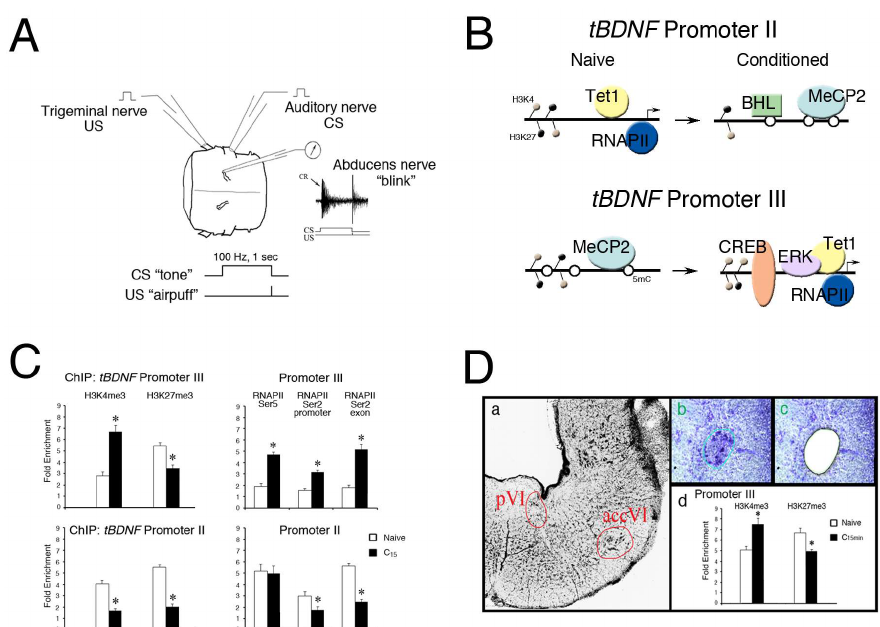
Figure 1. ( A ) Model of in vitro eyeblink classical conditioning. Illustration of the preparation of the pons isolated from the turtle brain showing cranial nerves that are stimulated and recorded. Classical conditioning is generated by paired stimulation of the auditory nerve (the “tone” conditioned stimulus, CS) with the trigeminal nerve (the “airpuff” unconditioned stimulus, US) while recording activity in the ipsilateral abducens nerve which controls blinking in this species. A physiological trace of abducens nerve discharge representative of a neural correlate of a “blink” conditioned response (CR, arrow) is shown. Pairing consists of a 100 Hz, one-second-duration CS to the auditory nerve which precedes a single shock US to the trigeminal nerve. Conditioning is usually recorded after about 50 paired stimuli or in about 1 h; ( B ) Schematic illustration of the epigenetic events controlling tBDNF transcriptional regulation during classical conditioning. Promoter II is initially bound by Tet1 and hypomethylated in the naïve state as it is actively transcribed by RNAPII. After 15 min of conditioning, Tet1 dissociates and promoter II is transcriptionally repressed by enhanced methylation (open circles) and binding by MeCP2 and BHLHB2. This is associated with a reduction in both H3K4me3 and H3K27me3 histone modifications. Promoter III is initially methylated and bound by MeCP2 in the naïve state. Conditioning induces demethylation by Tet1, dissociation of MeCP2, and a more open chromatin structure favoring H3K4me3 deposition, allowing access of ERK1/2 and transcriptional activator CREB to initiate BDNF transcription and the signaling cascade underlying conditioning; ( C ) ChIP-qPCR assays reveal high levels of both H3K4me3 and H3K27me3 histone modifications for tBDNF promoters II and III in naïve preparations. After 15 min of conditioning, H3K4me3 is significantly elevated ( p < 0.0001) while H3K27me3 is reduced ( p < 0.01) in tBDNF promoter III. The H3K4me3 and H3K27me3 marks for promoter II were both significantly reduced by conditioning ( p < 0.0001). ChIP of RNAPIISer2 and Ser5 binding to promoter III showed markedly elevated signals after conditioning ( p < 0.0001) compared to the naïve state, indicating active transcription. For promoter II, RNAPIISer5 binding showed surprisingly high values compared to the naïve state; however, RNAPIISer2 at both promoter and exonic sites was significantly lower than the naïve state ( p < 0.001), suggesting it is stalled; ( D ) Evidence for tBDNF bivalent domains from samples of the abducens motor nuclei obtained by laser microdissection (LMD). Thionin-stained section of the pons (a) showing the two abducens motor nuclei, the principal (pVI) and accessory (accVI), which are spatially separated. The accessory abducens nucleus was demarcated (b) and the cells recovered by LMD (c). Subsequent ChIP-qPCR assays (d) demonstrated bivalent histone modifications in naïve and conditioning-dependent alterations in tBDNF promoter III within the region of the CREB binding site. Approximately 20 slices obtained from LMD of the abducens nuclei were pooled [48]. ( A , C ), adapted from reference